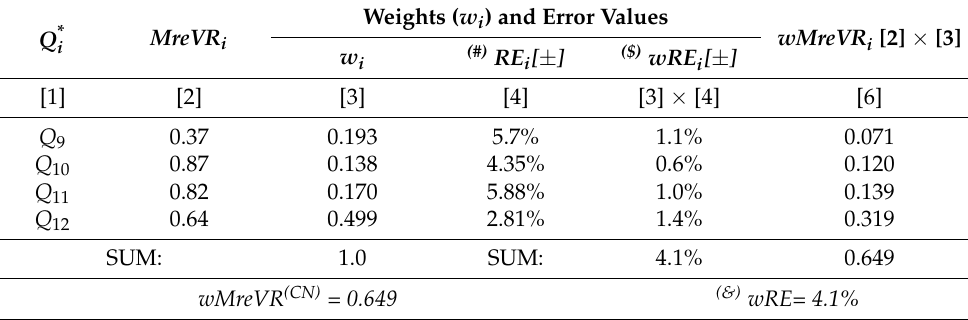
Table 15. Input for wMreVR (CN)